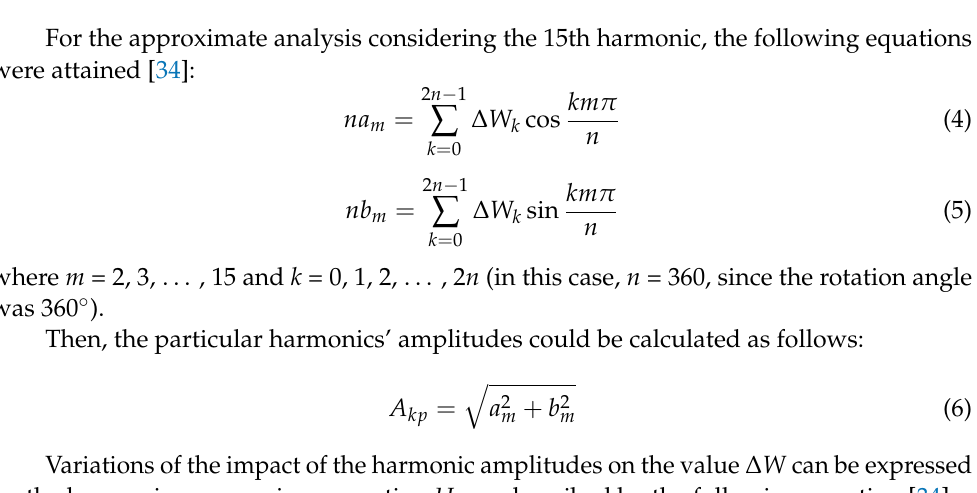
Figure 6. Roundness profile derived from variations of indications from the gauges G3, G1, and G2